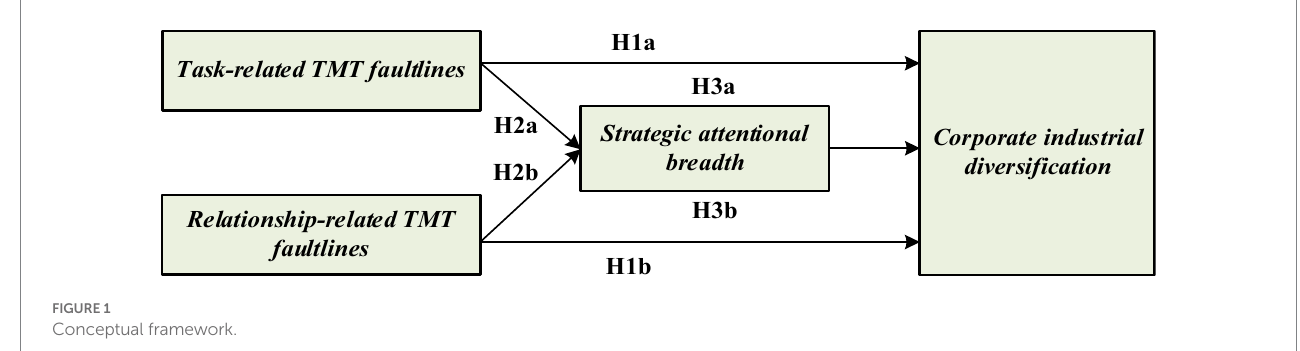
FIGURE 1 Conceptual